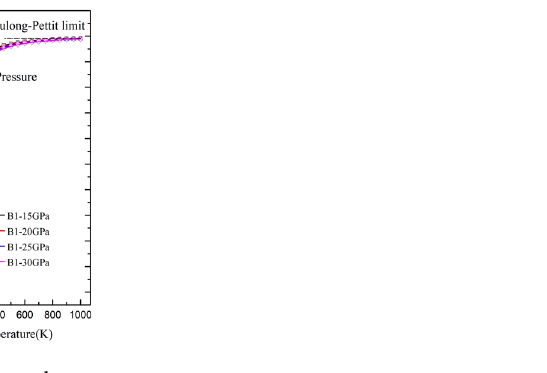
Figure 8. Heat capacity of ZnSe vs . temperature and